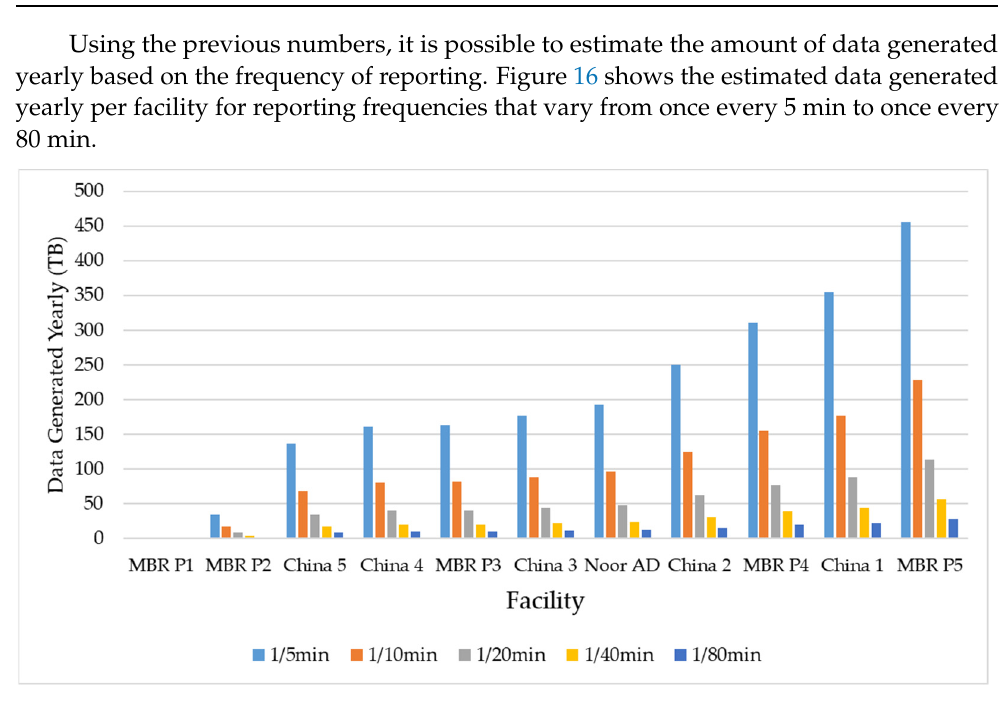
Table 4. Breakdown of amount of estimated data per reporting period transmitted per category for each facility.